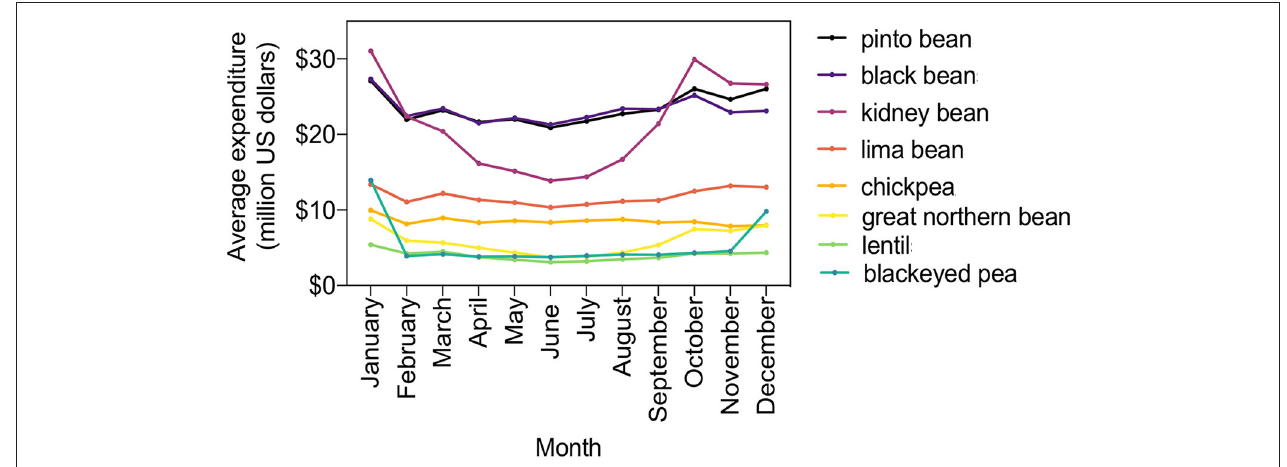
FIGURE 4 | Monthly expenditures on the top eight legumes in the US based upon Nielsen retail grocery scanning data, average over 2017–2019